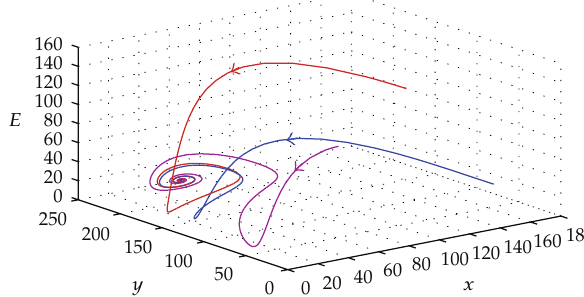
Figure 2: Phase space trajectories corresponding to the optimal tax τ δ (cid:6) 15 . 1, with reference to the di ff erent initial levels, we know that the optimal equilibrium (cid:4) 52.88, 223.90, 11.48 (cid:5) is asymptotically